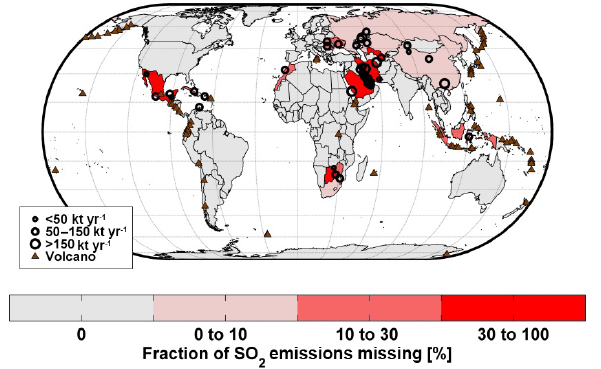
Figure 6. Point sources of SO 2 identified that were found to be missing from three leading bottom-up inventories (from McLin- den et al., 2016b). Each nation is color-coded according to its to- tal fraction of SO 2 emissions that are missing, relative to its total national emissions (the sum of Hemispheric Transport of Air Pollu- tion, HTAP, emissions and missing